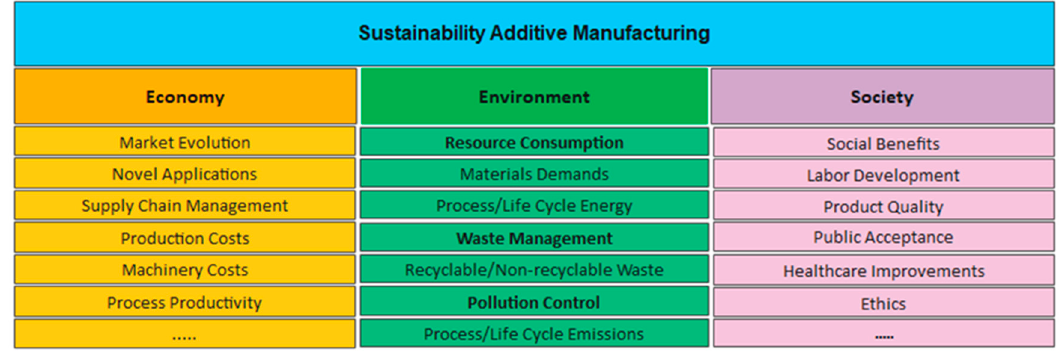
Figure 9. Sustainability dimensions of additive manufacturing [117].